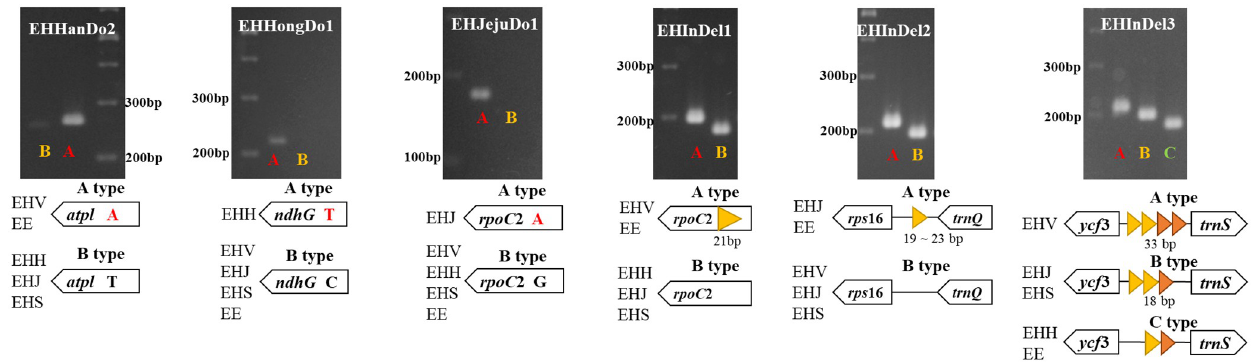
Fig 6. Representative genotypes and scheme used to develop barcoding markers. EHV: E . hamiltonianus (Hantaek), EHH: E . hamiltonianus (Hongcheon), EHJ: E . hamiltonianus (Jeju), EHS: E . hamiltonianus (‘Snow’), EE: E . europaeus . https://doi.org/10.1371/journal.pone.0275590.g006 In this study, we developed six markers to distinguish individuals of E . hamiltonianus col- lected from various sources. According to marker validation results, it was possible to divide our E . hamiltonianus individuals into five groups (S3 Fig). Different marker combinations could be applied to identify the genotype of each group; Hantaek (EHV) genotype: EHHanDo2, EHInDel1, and EHInDel3. Hongcheon (EHH) genotype: EHHongDo1 and EHInDel3. Jeju (EHJ) genotype: EHJejuDo1. Cultivar ‘Snow’ (EHS) genotype:EHInDel2, and EHInDel3. Others: EHJejuDo1, EHInDel2, and EHInDel3. Single markers such as EHHongDo1 and EHInDel3 can be used to identify the Hongcheon genotype and Hantaek genotype, respectively. However, it would be better to use multiple markers to avoid misidenti- fication. We expect that the six markers developed in this study will help to assess genotypes and genetic diversity for conservation of E . hamiltonianus .